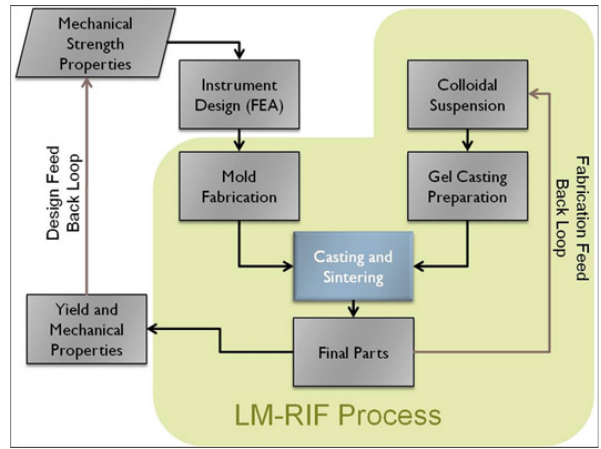
Figure 3. The LM-RIF flowchart. The process starts with a the- oretically optimized mechanical design based on initial determina- tion of mechanical properties, followed by mold fabrication, col- loidal processing, and final part fabrication. Final parts are tested and characterized, with the mechanical properties used to design changes in the design and fabrication for future generations of ma- terials and / or design components. Changes in the design geometry of the part are completed through the Design Feedback loop, while changes to the manufacturing process and material system are com- pleted through the Fabrication Feedback